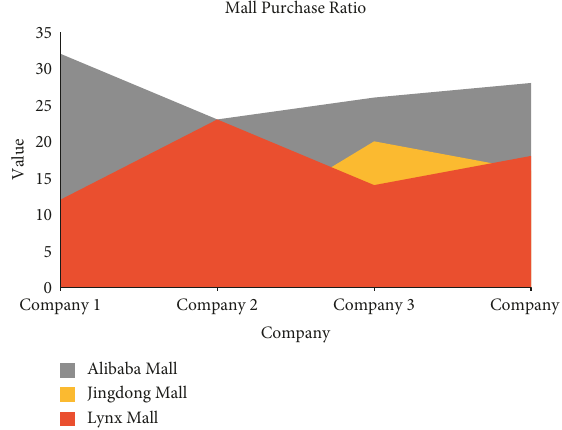
Figure 3: Experimental analysis of the use of nanomaterials purchase on various e-commerce platforms.